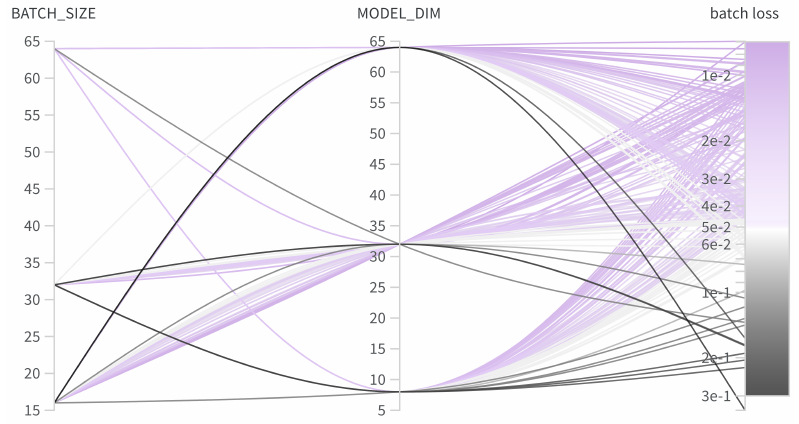
Figure 5. Hyperparameter optimization